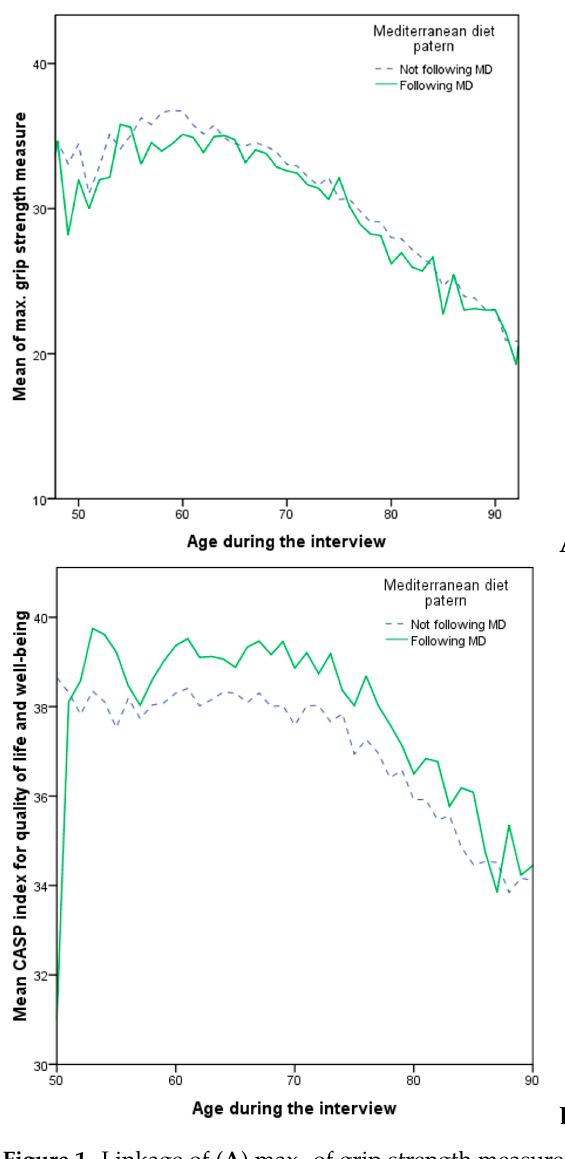
Figure 1. Linkage of ( A ) max. of grip strength measure and ( B ) index for quality of life and well- being (CASP) for those participants (aged 50–90 years) who follow (or not follow) the patterns of the Mediterranean diet.